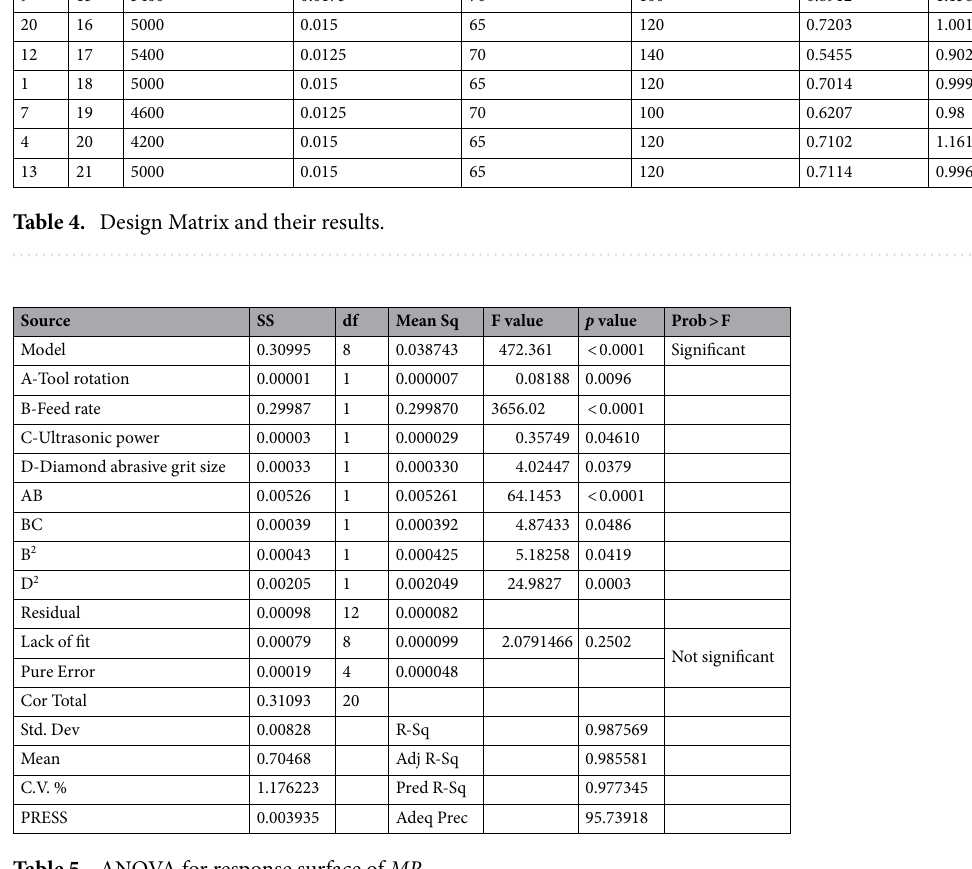
Table 5. ANOVA for response surface of